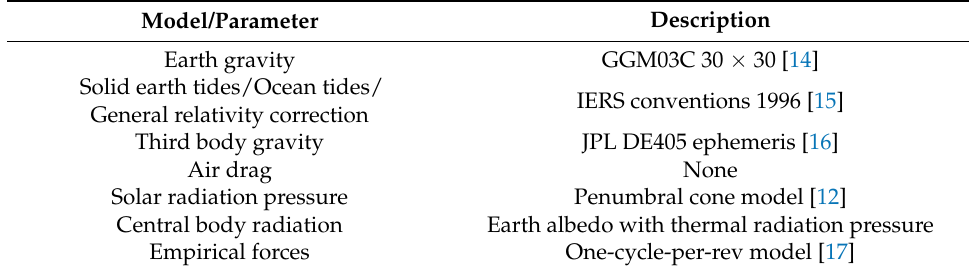
Table 6. Dynamic models, observation models, and estimation parameters for GK-2B OD.